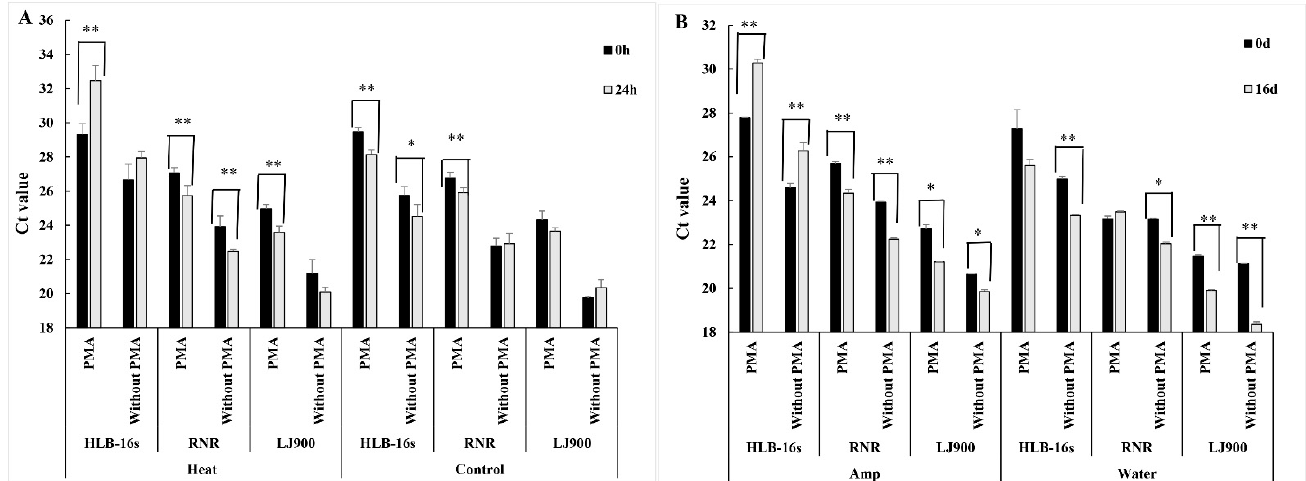
Figure 1. Ct value in HLB ‐ affected citrus cuttings treated with heat and chemical treatment via PMA ‐ qPCR using three different primer sets. ( A ) Heat treatment at temperature 60 °C; ( B ) Amp treatment (3000 ppm). Significant differences between different time points are indicated by * p ≤ 0.05 and ** p ≤ 0.01. Standard error of the mean is indicated by a vertical line. HLB ‐ 16S, RNR, and LJ900 indicate primer sets HLBas/HLBr, RNRf/RNRr and LJ900f/LJ900r, respectively. In the antimicrobial treatment (Amp), the analysis of variance indicated that there were significant differences in the Ct values between the PMA ‐ treated and untreated DNA with the HLBas/HLBr ( p = 0.0001), RNRf/RNRr ( p = 0.0082), and LJ900f/LJ900r ( p = 0.0044) primer sets (Table S2). Sixteen days after Amp treatment, the Ct values detected by HLBas/HLBr were significantly increased (Figure 1B), whereas the Ct values were sig ‐ nificantly reduced when using the RNRf/RNRr and LJ900f/LJ900r primer sets, under both